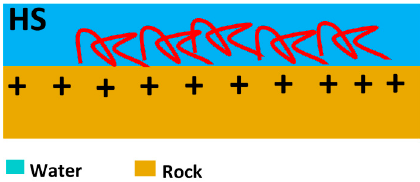
Figure 2. Schematic illustration of polymer degradation and adsorption in high-salinity water.